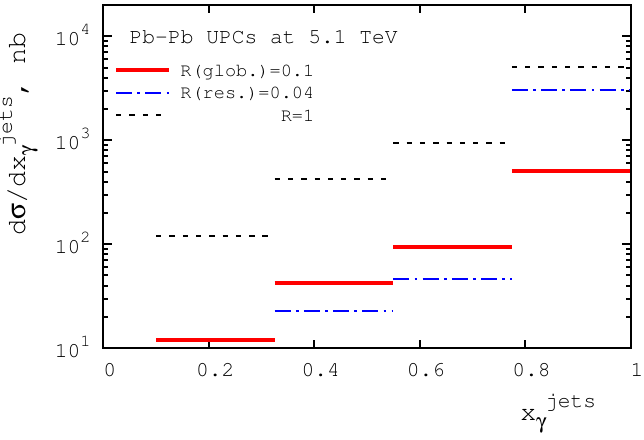
Figure 3: NLO pQCD predictions for the cross section of diffractive dijet photopro- duction in Pb-Pb UPCs at 5.1 TeV as a function of x γ for different scenarios of factor- ization breaking [ 11 ]